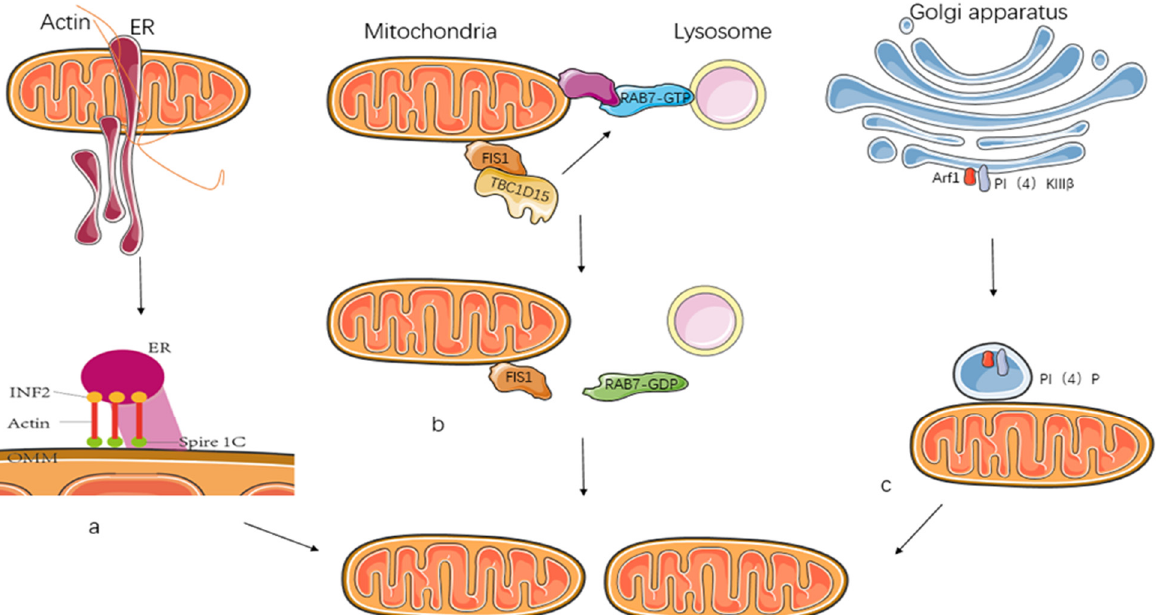
Figure 4. Interactions between mitochondria and other organelles promote mitochondrial fission.